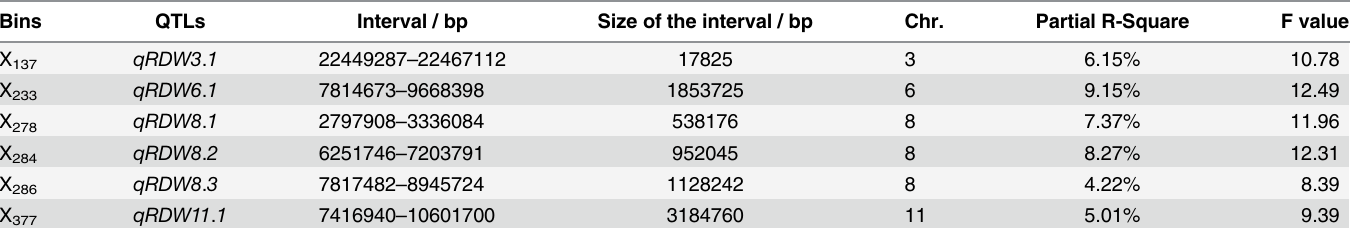
Table 5. QTLs mapping of RDW.